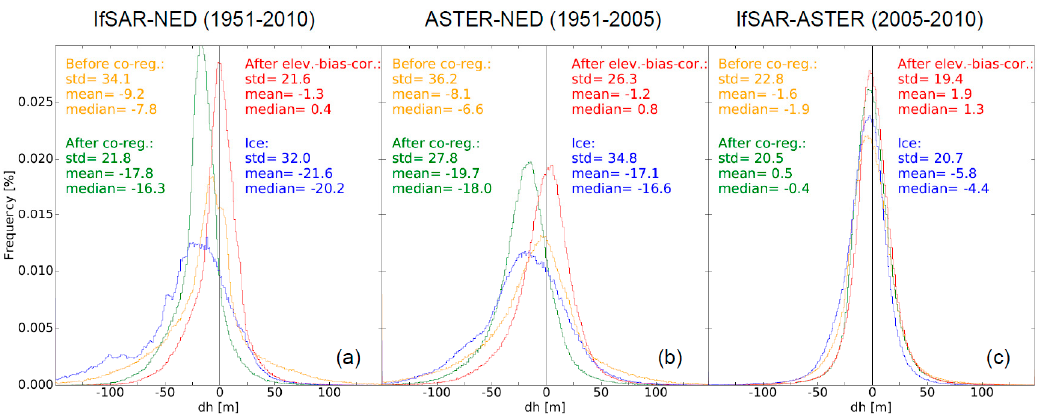
Figure 2. Frequency distribution of elevation changes dh over the periods ( a ) 1951–2010 (NED-IfSAR); ( b ) 1951–2005 (NED-ASTER); and ( c ) 2005–2010 (ASTER-IfSAR) across ice-free terrain before and after the corrections (yellow, green, and red), and over the glacierized area (blue). Bin size is 1 m. Glacier volume changes were computed for the three periods: 1951–2005 (ASTER-NED DEM),